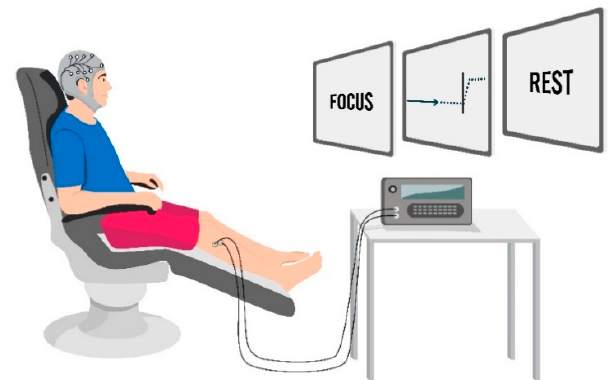
Figure 2. Intervention set-up. Participants observed the visual cue to prompt the timing of either voluntary or imagined dorsiflexion whilst receiving either suprathreshold (300%) stimulation, motor threshold stimulation (100%), or no stimulation (0%) to the right deep common peroneal nerve.